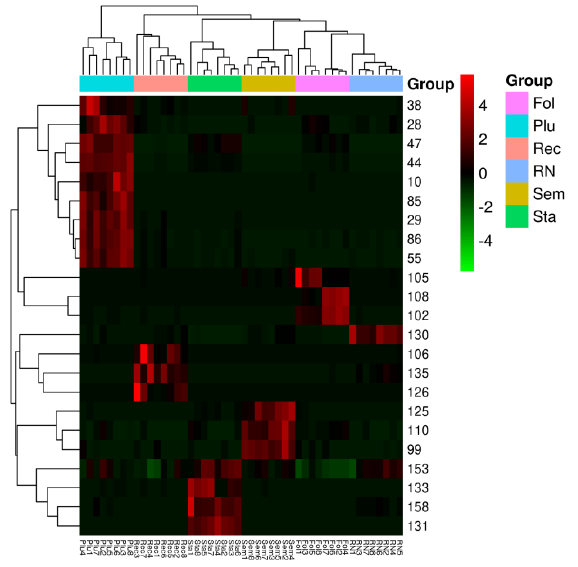
Figure 7. Heatmap visualizing the intensities of potential biomarkers.